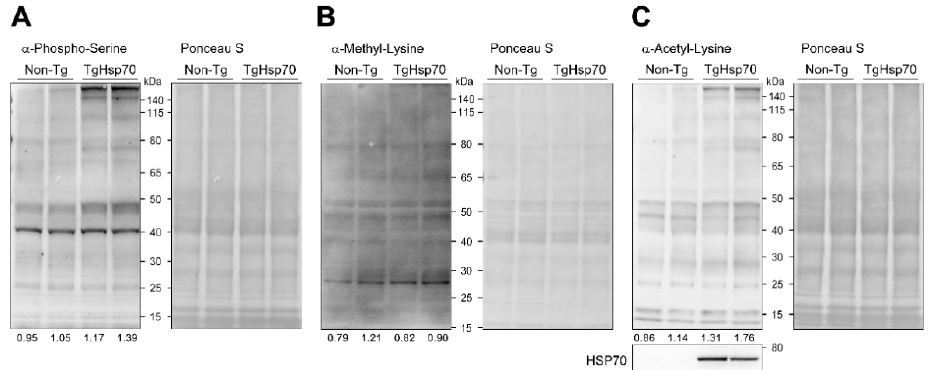
Figure 5. HSP70 modulates post-translational modifications. ( A – C ) Protein modifications in heart lysates obtained from TgHSP70 mice were compared to those in lysates from non-Tg littermates; phospho-serine (pSer, A ), methyl-lysine (MeK, B ), and acetyl-lysine (AcK, C ). Both serine phosphorylation and lysine acetylation were significantly increased in TgHSP70 hearts. Phosphorylation was predominantly changed. The numbers at the bottom of each figure indicate the results of densitometer analysis.